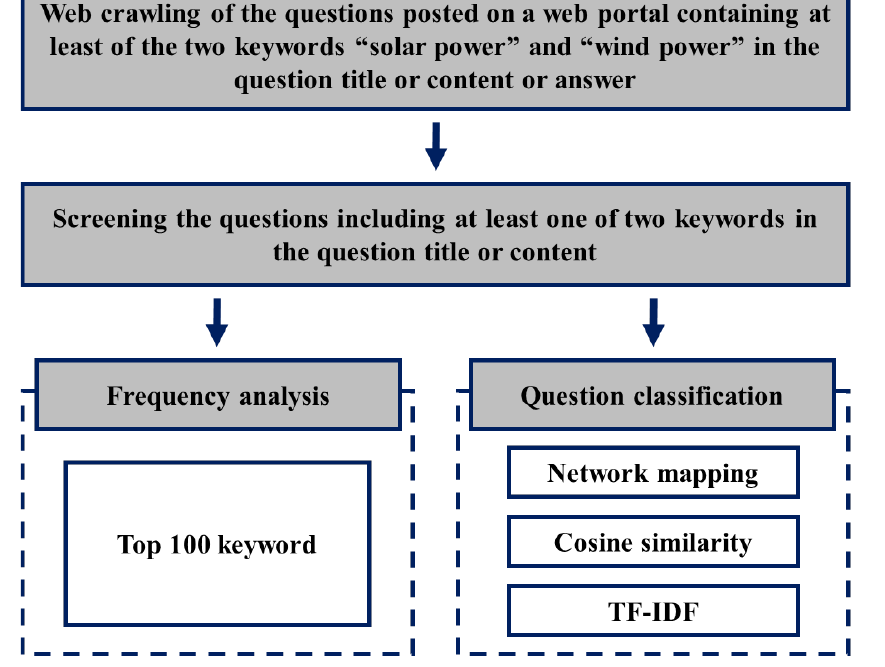
Figure 1. Overview of the analysis procedure.